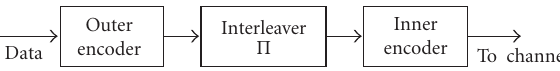
Figure 2: Serial concatenated